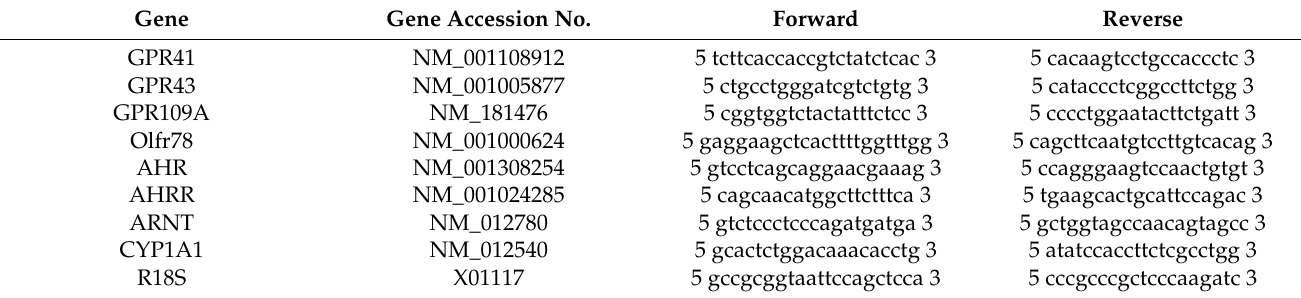
Table 1. PCR primer